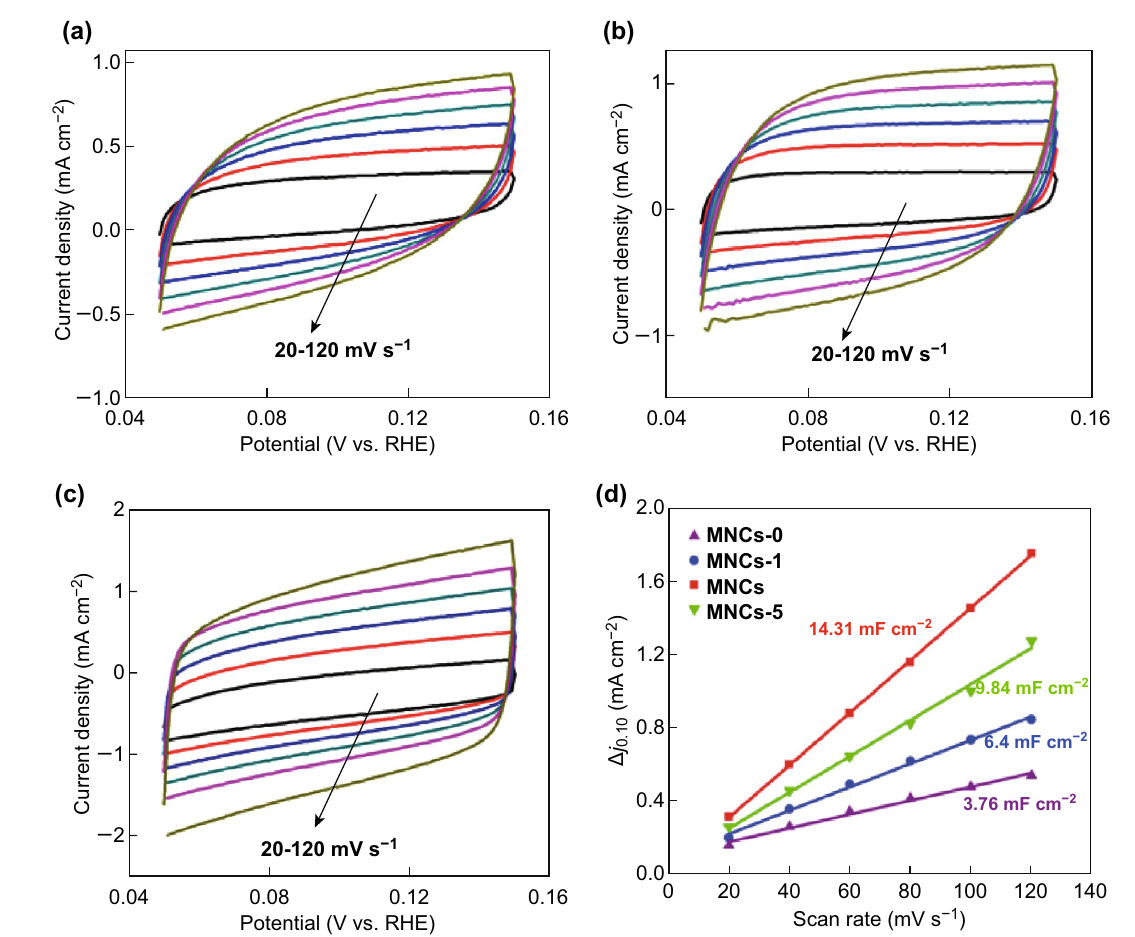
Fig. 5 CV curves of a MoNCs-0, b MoNCs-1, and c MoNCs-5. d The capacitive current of those four catalysts measured at 0.10 V versus RHE is plotted as a function of scan